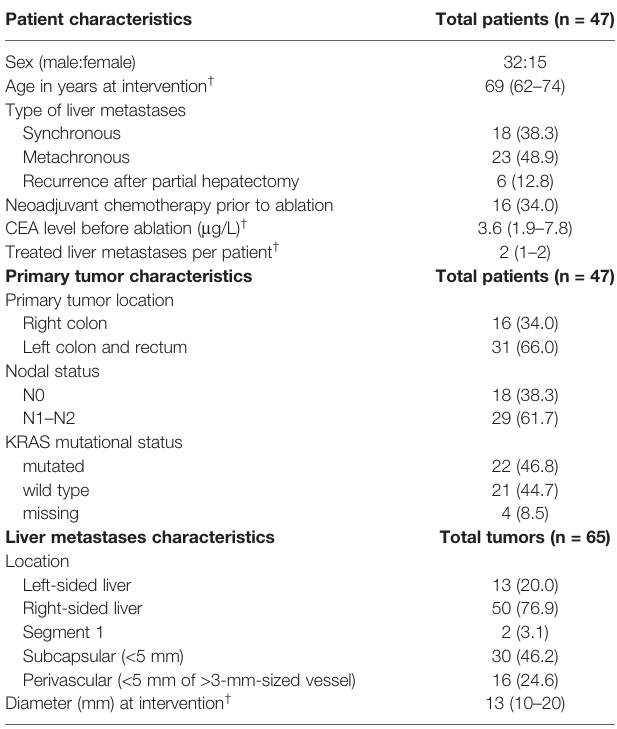
TABLE 1 | Clinicopathological characteristics.